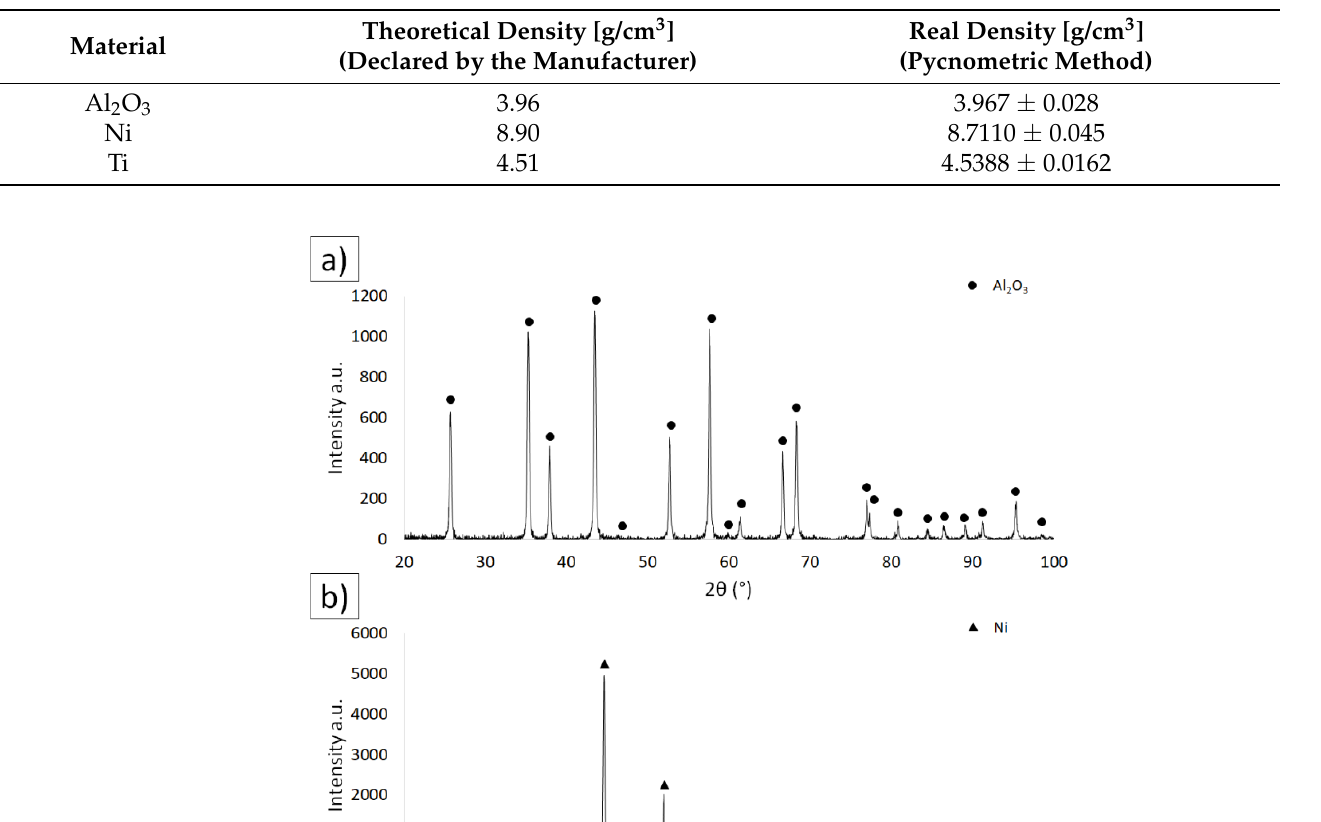
Table 3. Characteristics of the sample series included in the study.